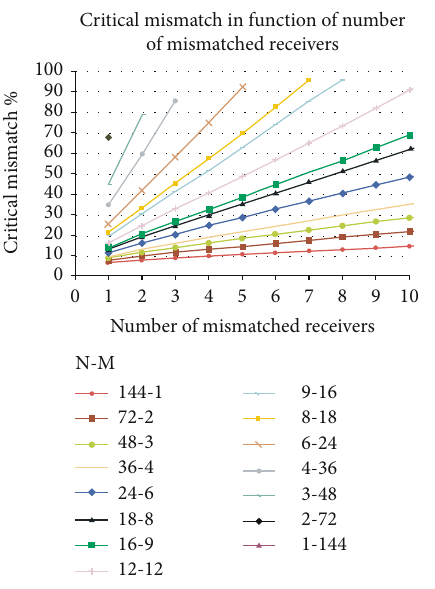
Figure 7: Critical mismatch values in function to the number of mismatched receivers for di ff erent electrical module layout con fi gurations